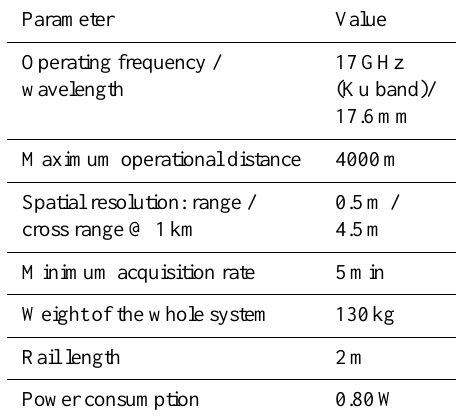
Table 1. Main parameters of the GB-SAR system used in this